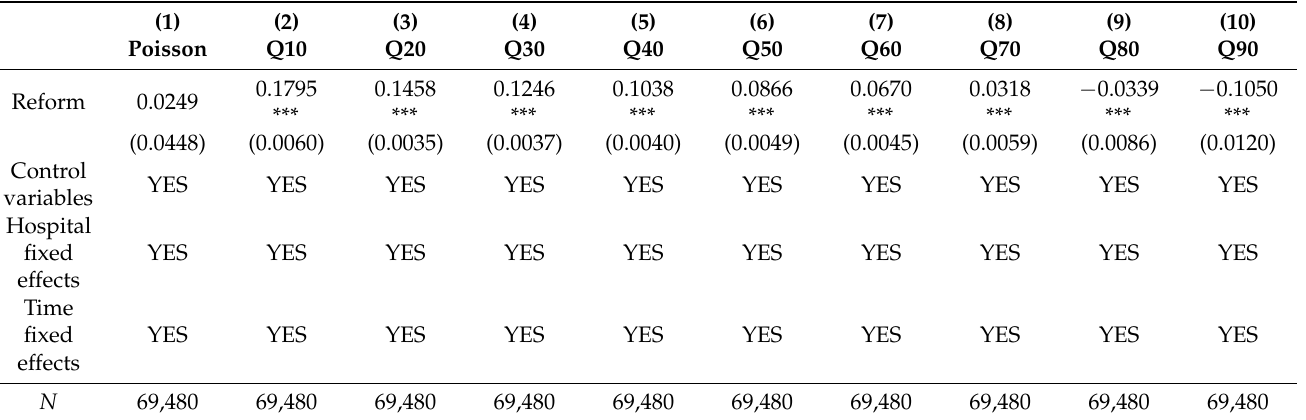
Table 4. Quantile difference-in-differences estimates of LOS.